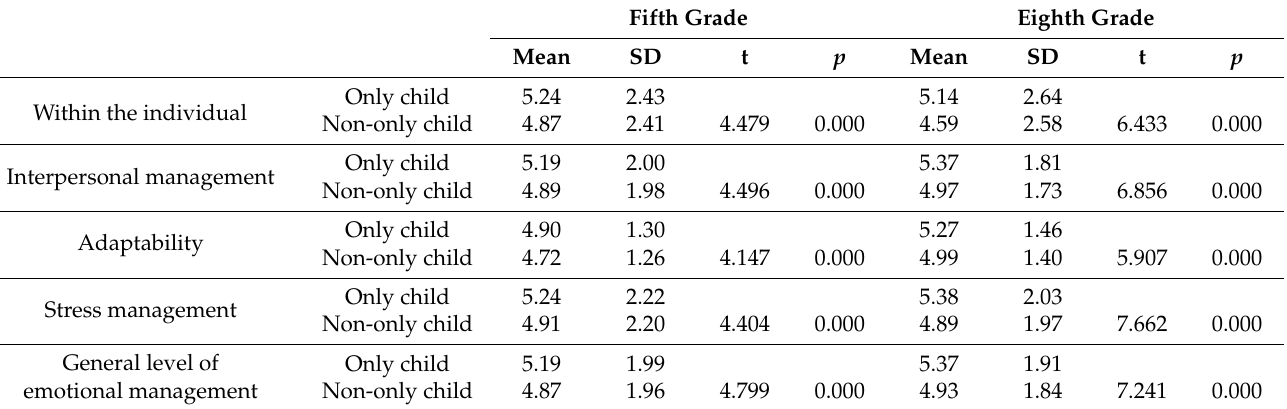
Table 5. Emotional management dimensions before matching.